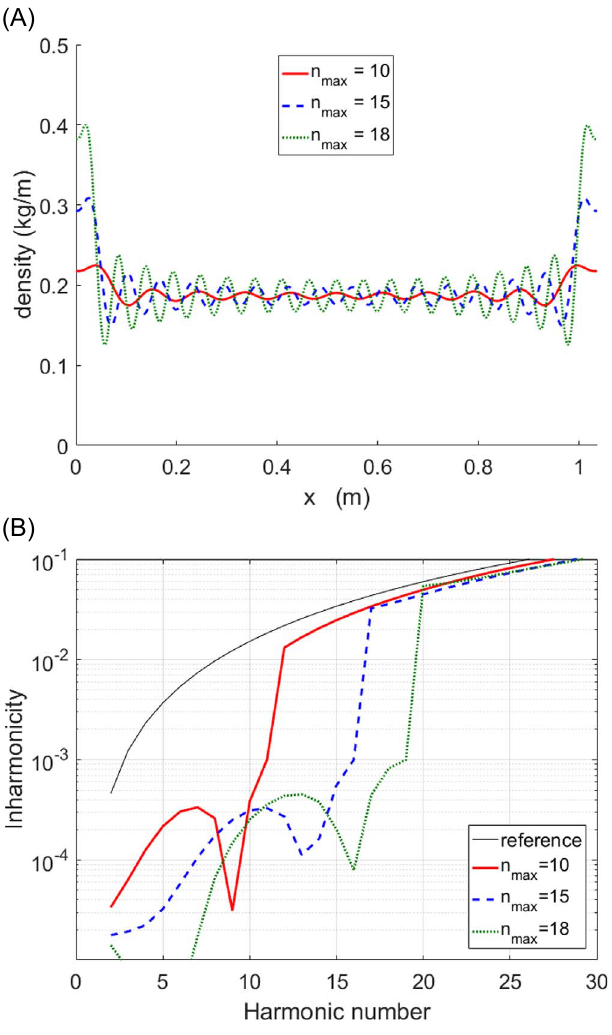
Figure 1. Result of an unconstrained optimization for a number of optimized harmonics equal to 10, 15 and 18 for a 1m string such that the inharmonicity factor (Eq. (1)) is B = 3.13 (cid:3) 10 (cid:2) 4 (from [11]). (A) Linear density versus position on the string. (B) Inharmonicity I ¼ 1 (cid:2) f n partial